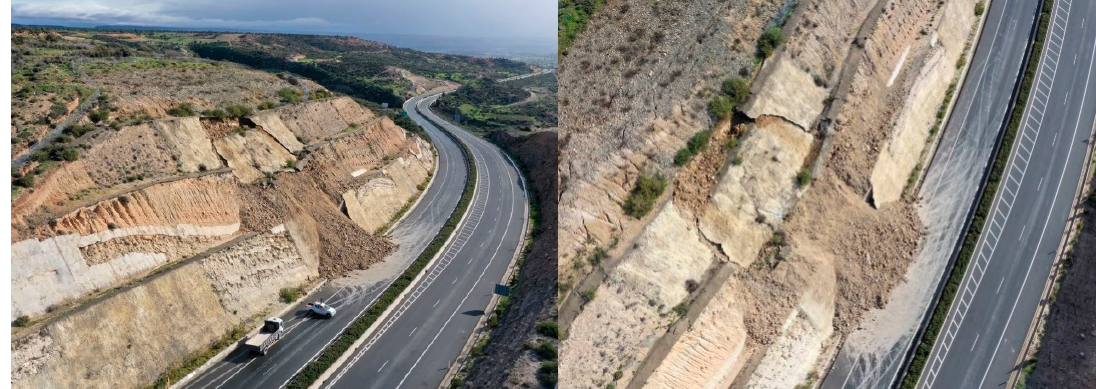
Figure 6. Side and top views of the landslide on the Paphos-Limassol motorway near Pissouri. Both photos were provided by the Geological Survey Department of